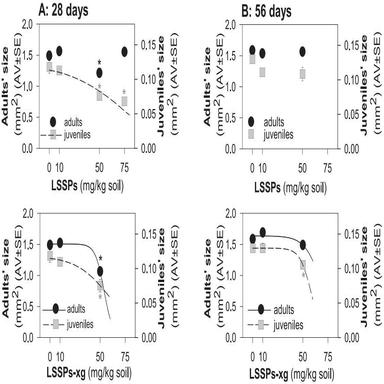
Results in terms of organisms' size when exposing Folsomia candida in LUFA 2.2 soil to LSSPs (Lipid Surfactant Submicron Particles) and LSSPs-xg (LSSPs without stabilizer xanthan gum), during A) 28 days and B) 56 days (extension for 2nd generation). Values represent adults' and juveniles' size (area, mm2 ) as average ± standard error (AV ± SE).